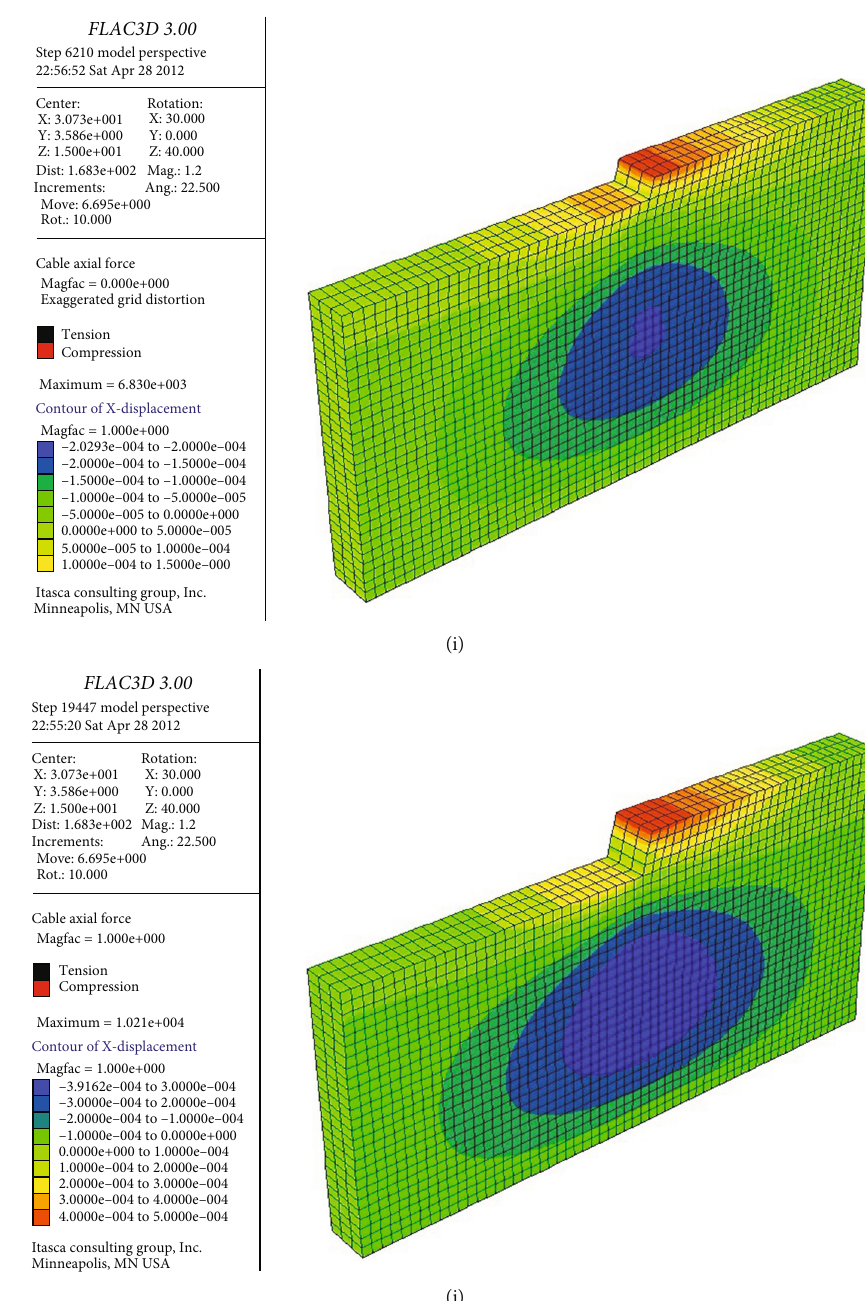
Figure 6: Contour map of soil horizontal displacement during excavation of foundation pit (a) –